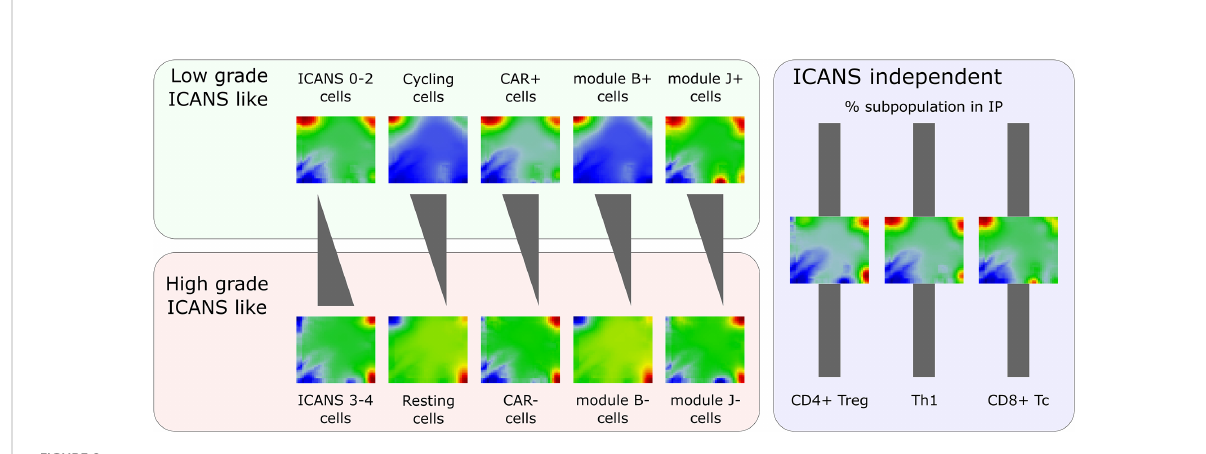
FIGURE 9 Portraying of single-cell transcriptome landscapes illustrates that neurotoxicity associates with decreasing cycling activity, amount of CAR+ cells, and expression of modules B (cell cycle genes) and J (exhaustion related genes LAG3 and TIM3). The composition of the infusion product (IP) regarding different T cell types is virtually invariant. The fi gure shows mean expression portraits of all single T cells strati fi ed by ICANS group, cell cycle phase (S & G2M versus G1), CAR status, and expression of modules B and J,